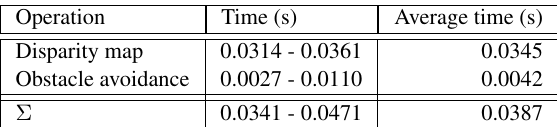
Table 1. Runtime measurements of the proposed system achieved on a Xilinx Zynq Ultrascale+.